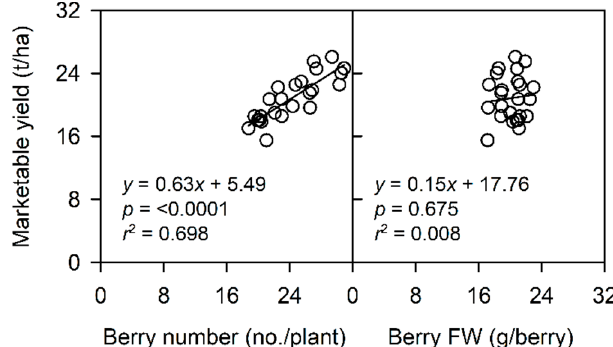
Figure 3. Linear regression between berry number and yield or average berry fresh weight (FW) and yield of ‘Florida Radiance’ strawberry. Data from the 2015–16 and 2016–17 seasons are included in the figure. The correlation was considered significant when the slope was significantly different from zero ( p ≤ 0.05).